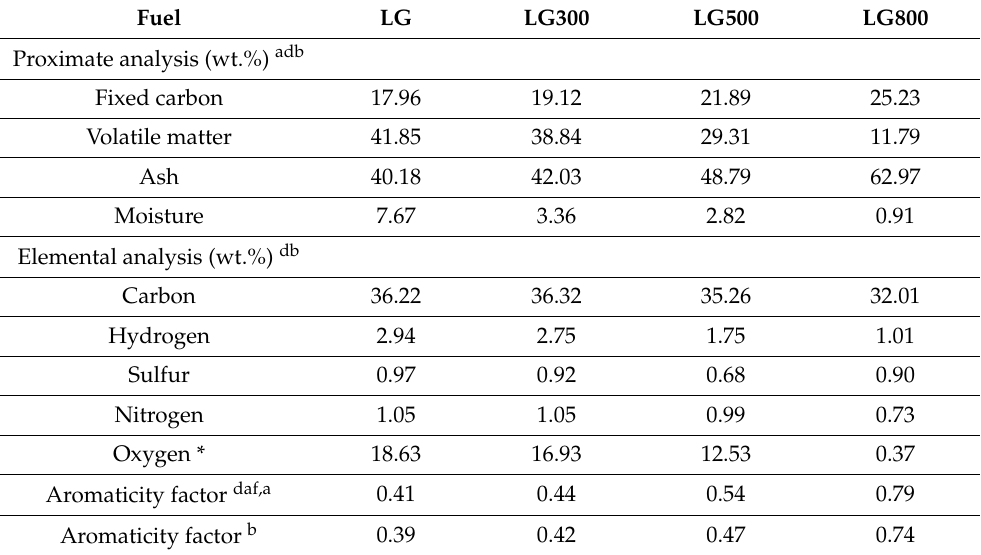
Table 1. Proximate and ultimate analysis of fuel